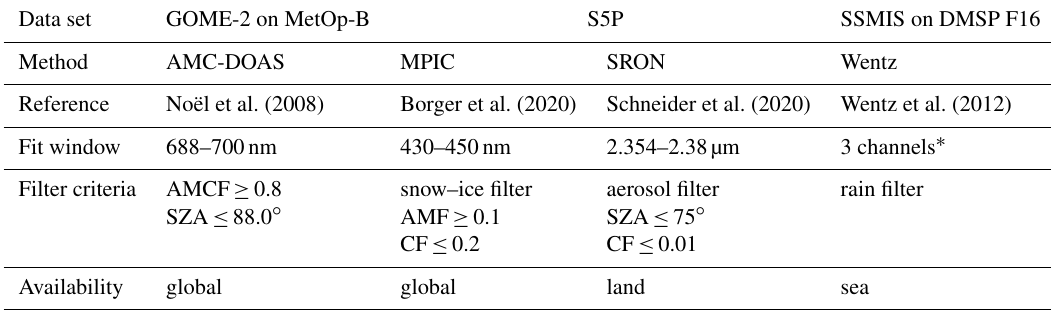
Table 1. Overview of the satellite TCWV data sets used in the study. CF is the cloud fraction, AMF is the air mass factor, AMCF is the air mass correction factor and SZA is the solar zenith